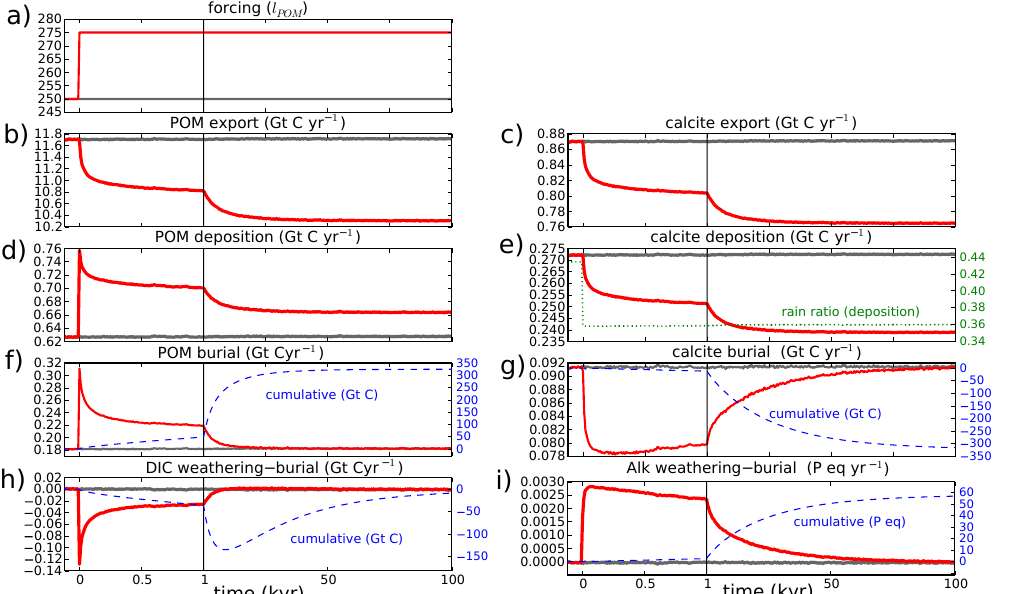
Figure 3. Globally integrated, annual mean fluxes for the control run (grey, l POM = 250m) and the perturbation experiment (red, l POM = 275m). Note the different time axis for the first 1kyr. Carbon fluxes are reported in gigatons of carbon (GtC) and alkalinity fluxes in petaequivalents (Peq) (left y axis) per year. The blue dashed lines (right y axis) show cumulative fluxes , i.e. cumulative differences w.r.t. the control experiment. Weathering fluxes are kept constant in all experiments. The change in the ratio of the deposition flux of POC to CaCO 3 is shown by the green dotted line in (e)